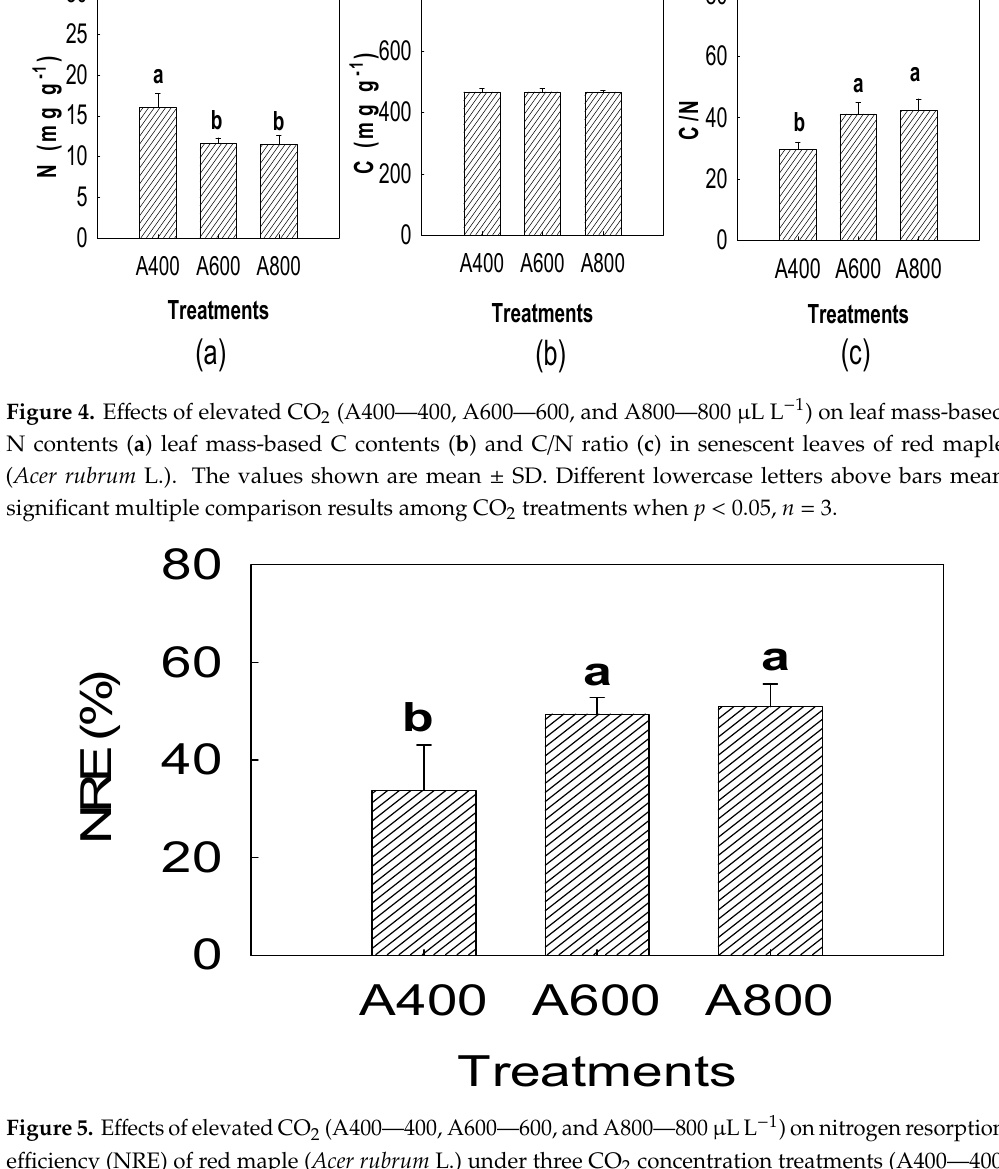
Figure 5. E ff ects of elevated CO 2 (A400—400, A600—600, and A800—800 µ L L − 1 ) on nitrogen resorption e ffi ciency (NRE) of red maple ( Acer rubrum L.) under three CO 2 concentration treatments (A400—400, A600—600, and A800—800 µ L L − 1 ). The values shown are mean ± SD. Di ff erent lowercase letters above bars mean significant multiple comparison results among CO 2 treatments when p < 0.05, n =